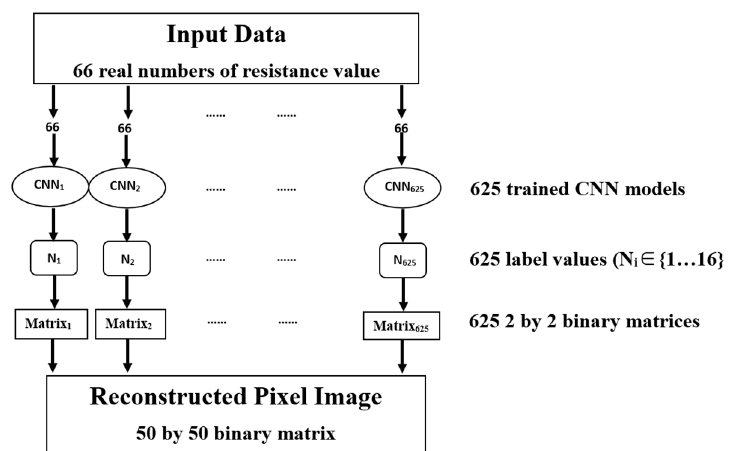
Figure 3. The reconstruction processes.